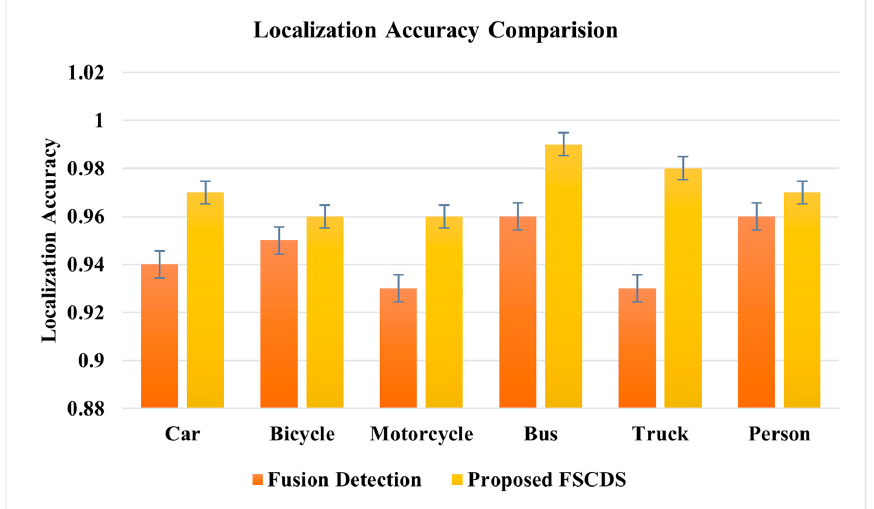
Figure 18. Localization accuracy comparison of fusion detection and FSCDS.